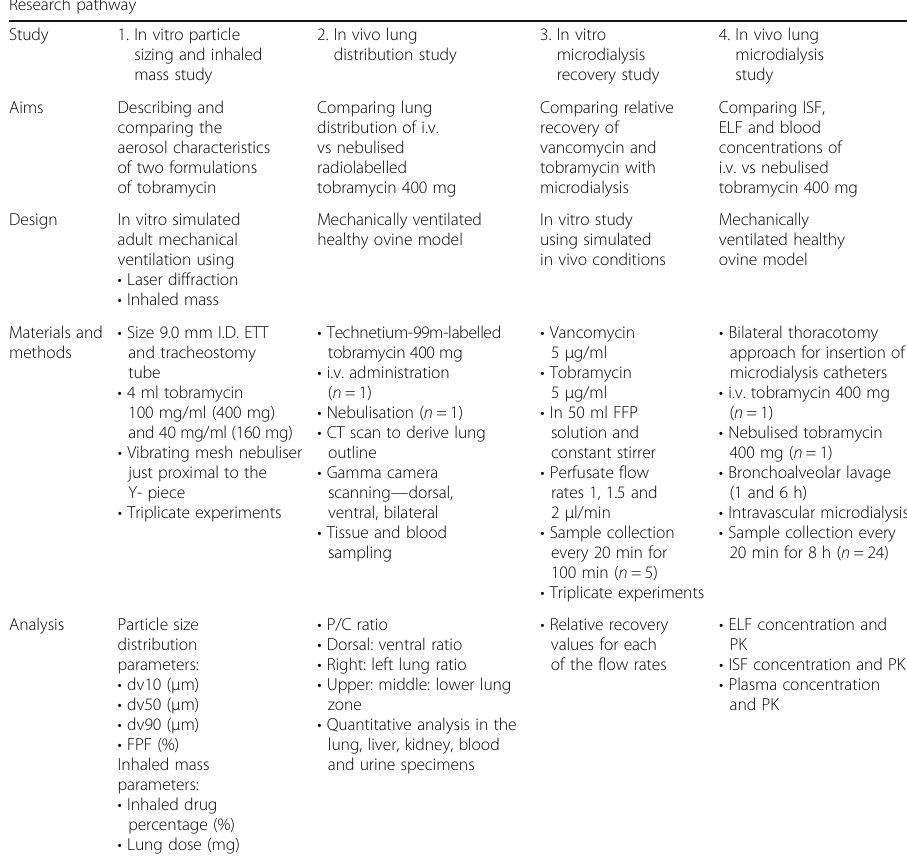
Table 1 Overview of the research pathway with the study components aimed at characterising the pharmacokinetics of nebulised